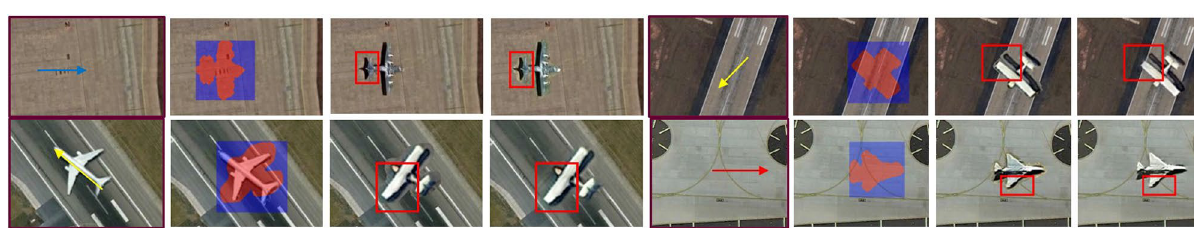
Figure 11. Examples of ATSS-1 vs pixel collage (naive copy-and-paste). The purple border presents the real scenes. The arrows represent the relevant parameters of the ATSS-1, including geographical coordinates, embedding type, direction, and resolution. The red-coloured region and blue-coloured region in columns 2,6 present the blending mask, where red represents the collage area and blue represents areas that are not collaged. Column 3,7 represent pixel collage. Columns 4,8 depict the Poisson